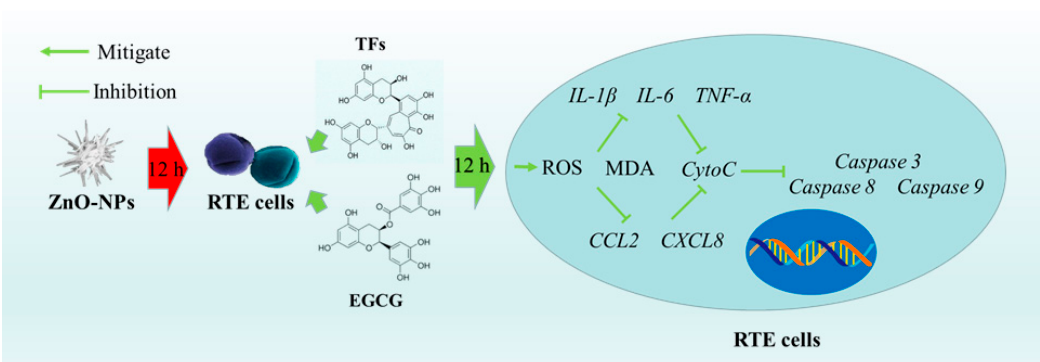
Figure 6. TFs and EGCG treatment mechanisms in mitigating the apoptosis of RTE cells induced by ZnO-NPs exposure.